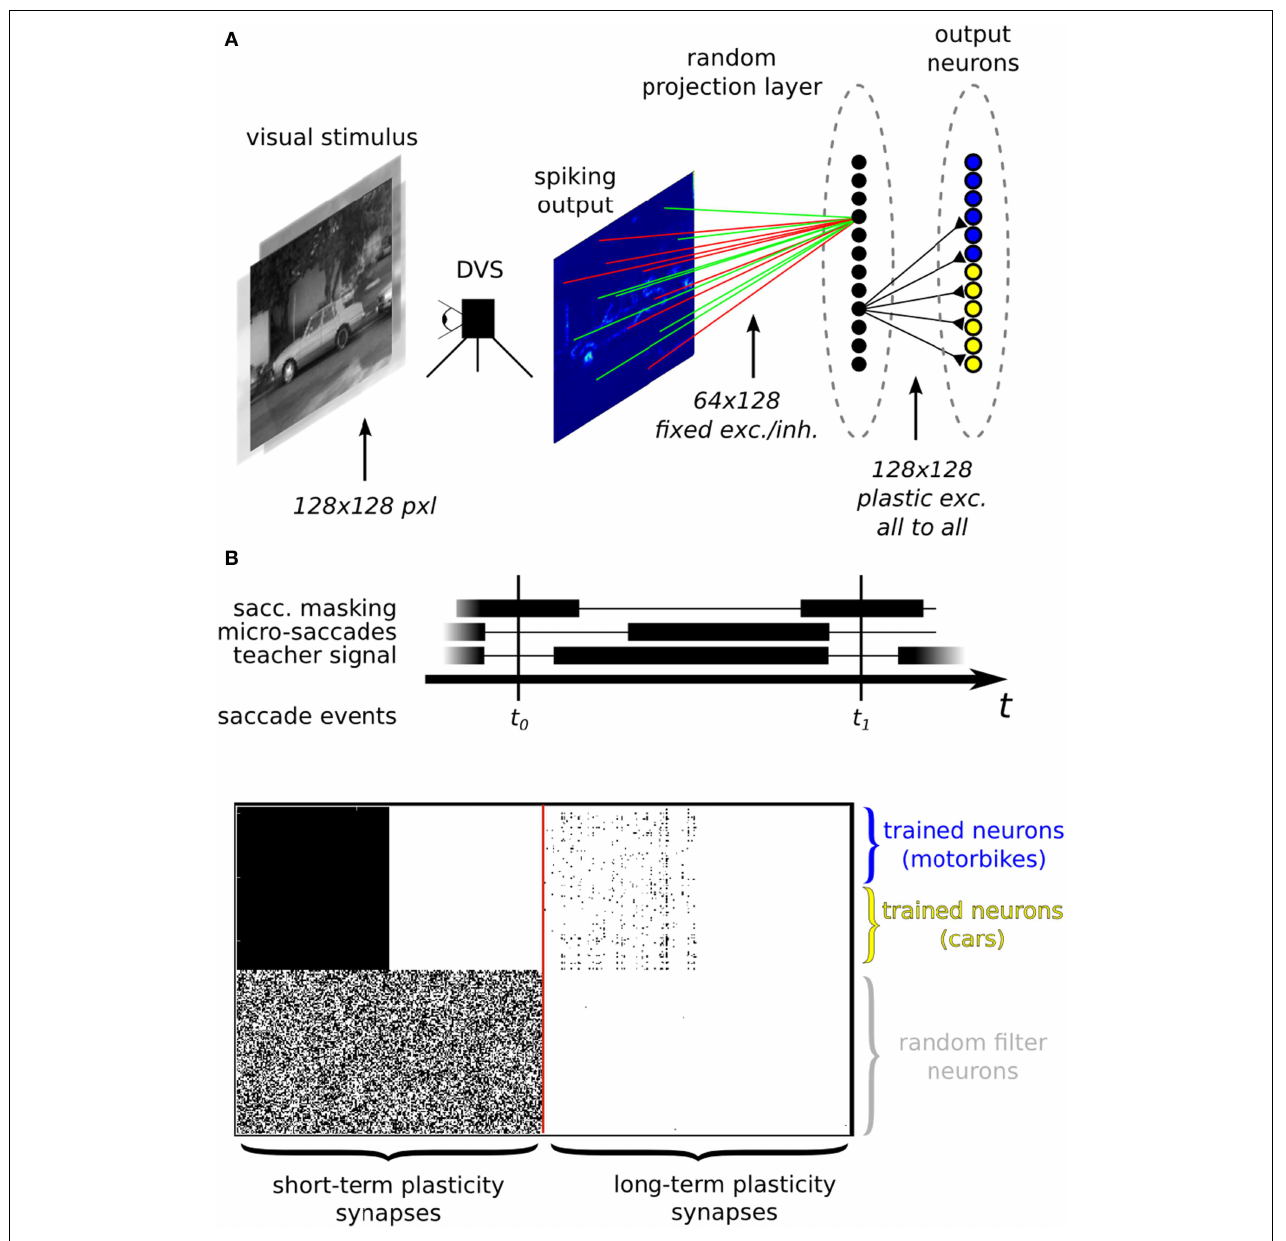
“teacher” signal which is correlated with one of the image classes. (A) Bottom: diagram of the experimental protocol timeline. Notice the presence of a saccade inhibition mechanism which electronically suppresses DVS input during a virtual saccade, i.e., when the displayed image is replaced with the next one. (B) Synaptic matrices of the ROLLS neuromorphic processor showing the hardware configuration of the classification neural network. The STP synapses represent the synapses of the hidden layer; the LTP synapses represent the synapses of the output